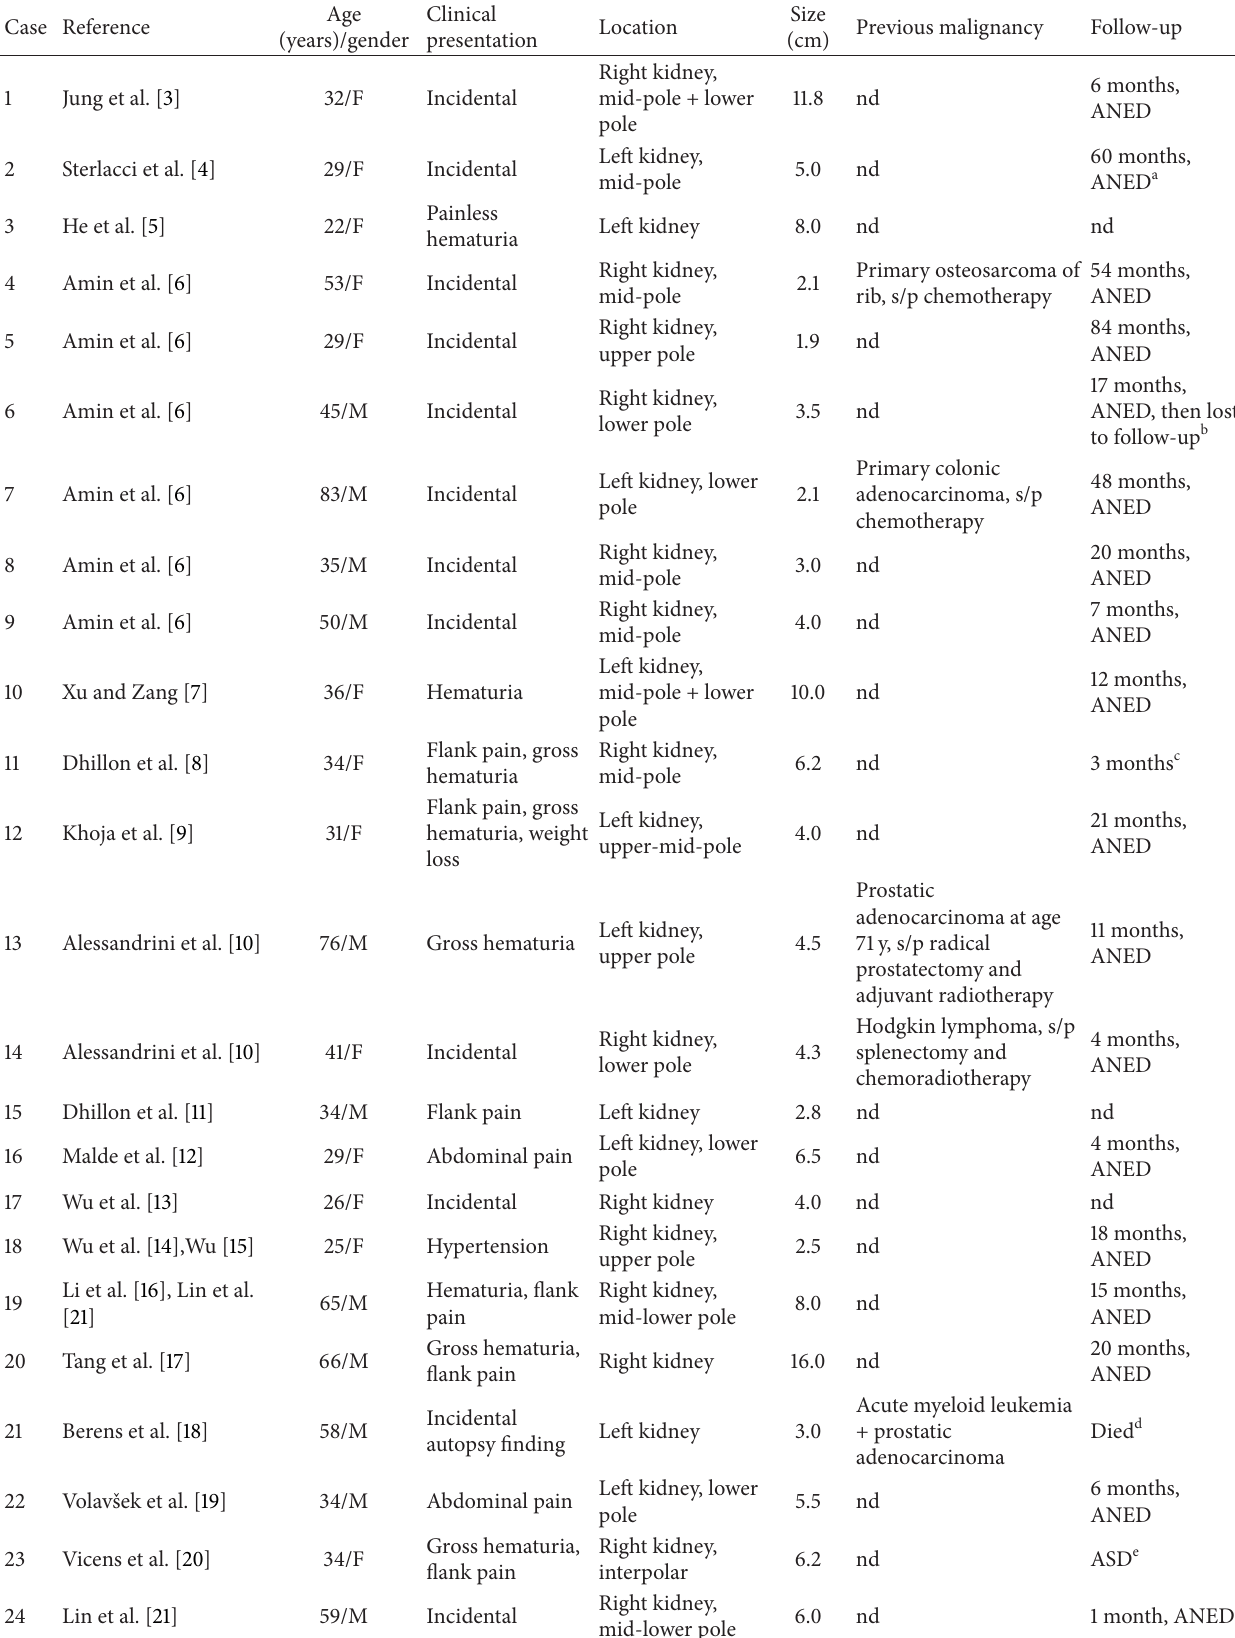
Table 1: Clinicopathological features of thyroid-like follicular carcinoma of the